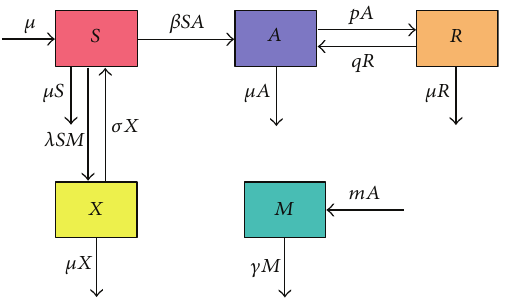
Figure 1: Transfer diagram of model